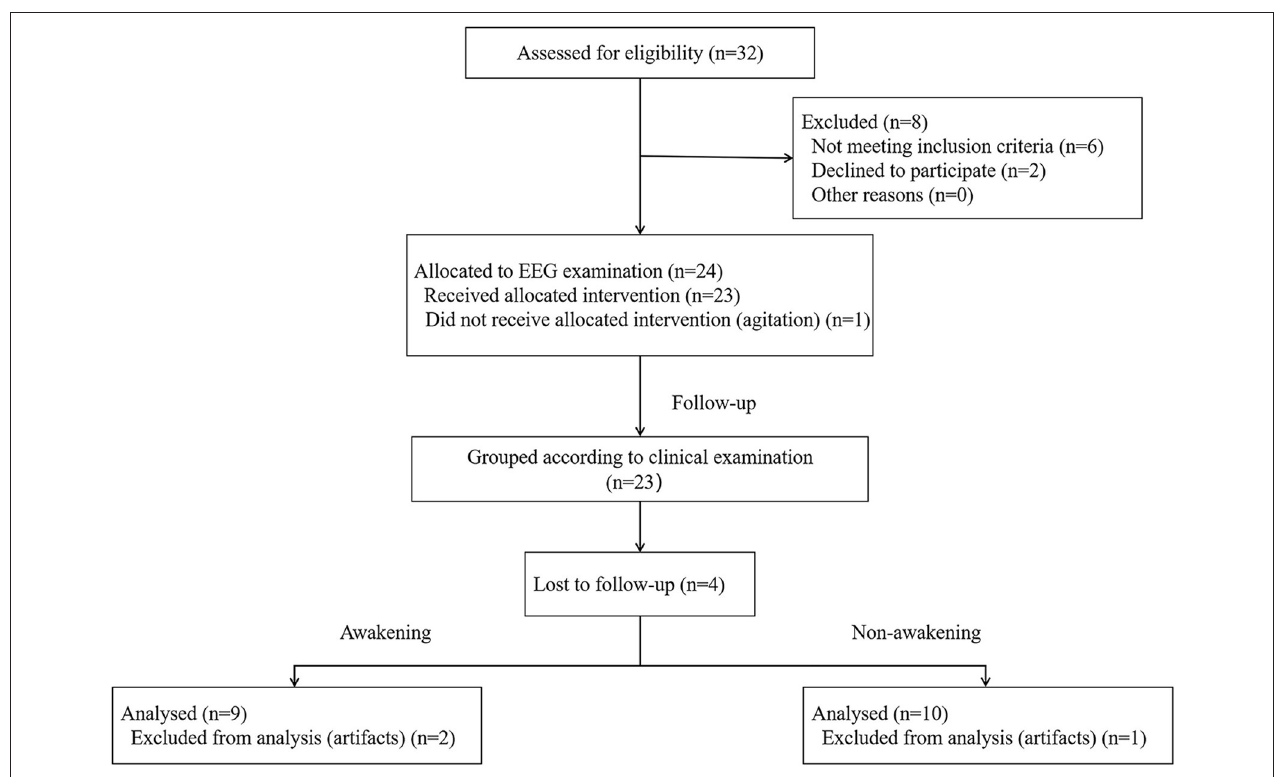
FIGURE 1 | Flow diagram of the patient screening and exclusion criteria. EEG,